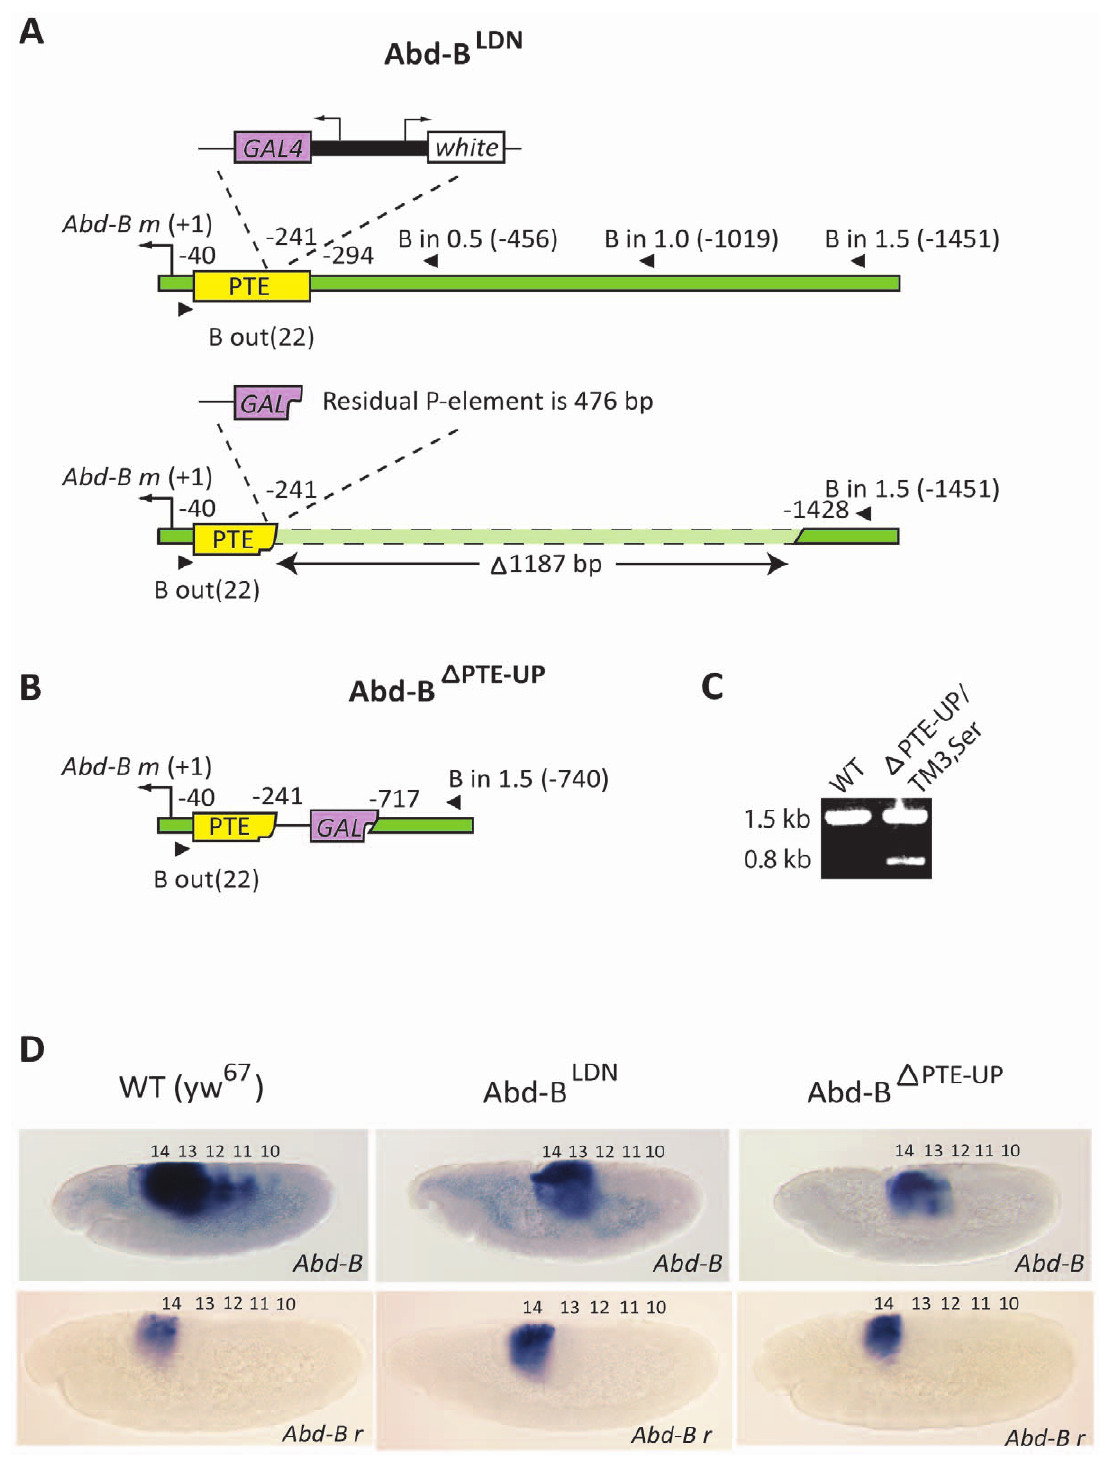
Figure 3. Deletion of the PTE and upstream sequences at the endogenous BX-C disrupts Abd-B expression. ( A ) The Abd-B LDN mutant features a P element inserted within the PTE (yellow box) ( 2 241 bp relative to the Abd-B transcription start site (black arrow)). The P element contains GAL4 (purple box) and white (white box) reporter genes. PCR primers (black triangles) designed against the Abd-B promoter region and 0.5 kb, 1 kb and 1.5 kb upstream of the Abd-B m transcription start site were used to characterize the approximately 1.2 kb deletion (dashed box) in the Abd- B D PTE-UP mutant generated by imprecise excision of the P element. ( B ) The resulting Abd-B D PTE-UP deletion removes 53 bp of the PTE sequence 5 9 of the original insertion site and an additional 1134 bp of endogenous sequence 5 9 of the PTE. A 476 bp portion of the GAL4 coding sequence (purple polygon) from the original P element remains, as well as 202 bp of the 3 9 PTE sequence (yellow polygon). ( C ) Primers designed against the Abd-B promoter region and 1.5 kb upstream of the Abd-B transcription start site were used to genotype adult flies carrying the deletion allele by amplifying the 1.5 kb wild-type (WT) band and the 0.8 kb Abd-B D PTE-UP band in balanced Abd-B D PTE-UP ( D PTE-UP/TM3,Ser) individuals. ( D ) In situ hybridization